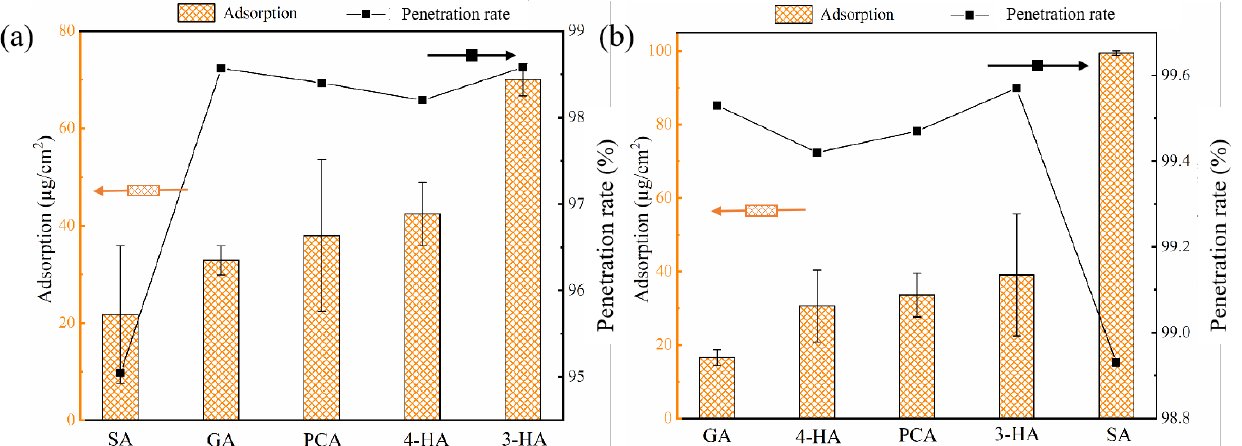
Figure 7. The correlations between amounts of phenolic acids adsorbed onto the two membranes (( a ), for RC membrane; ( b ), for PA membrane) and the penetration rates. Experimental conditions: feed concentration = 10 mM and 25 ± 2 °C.